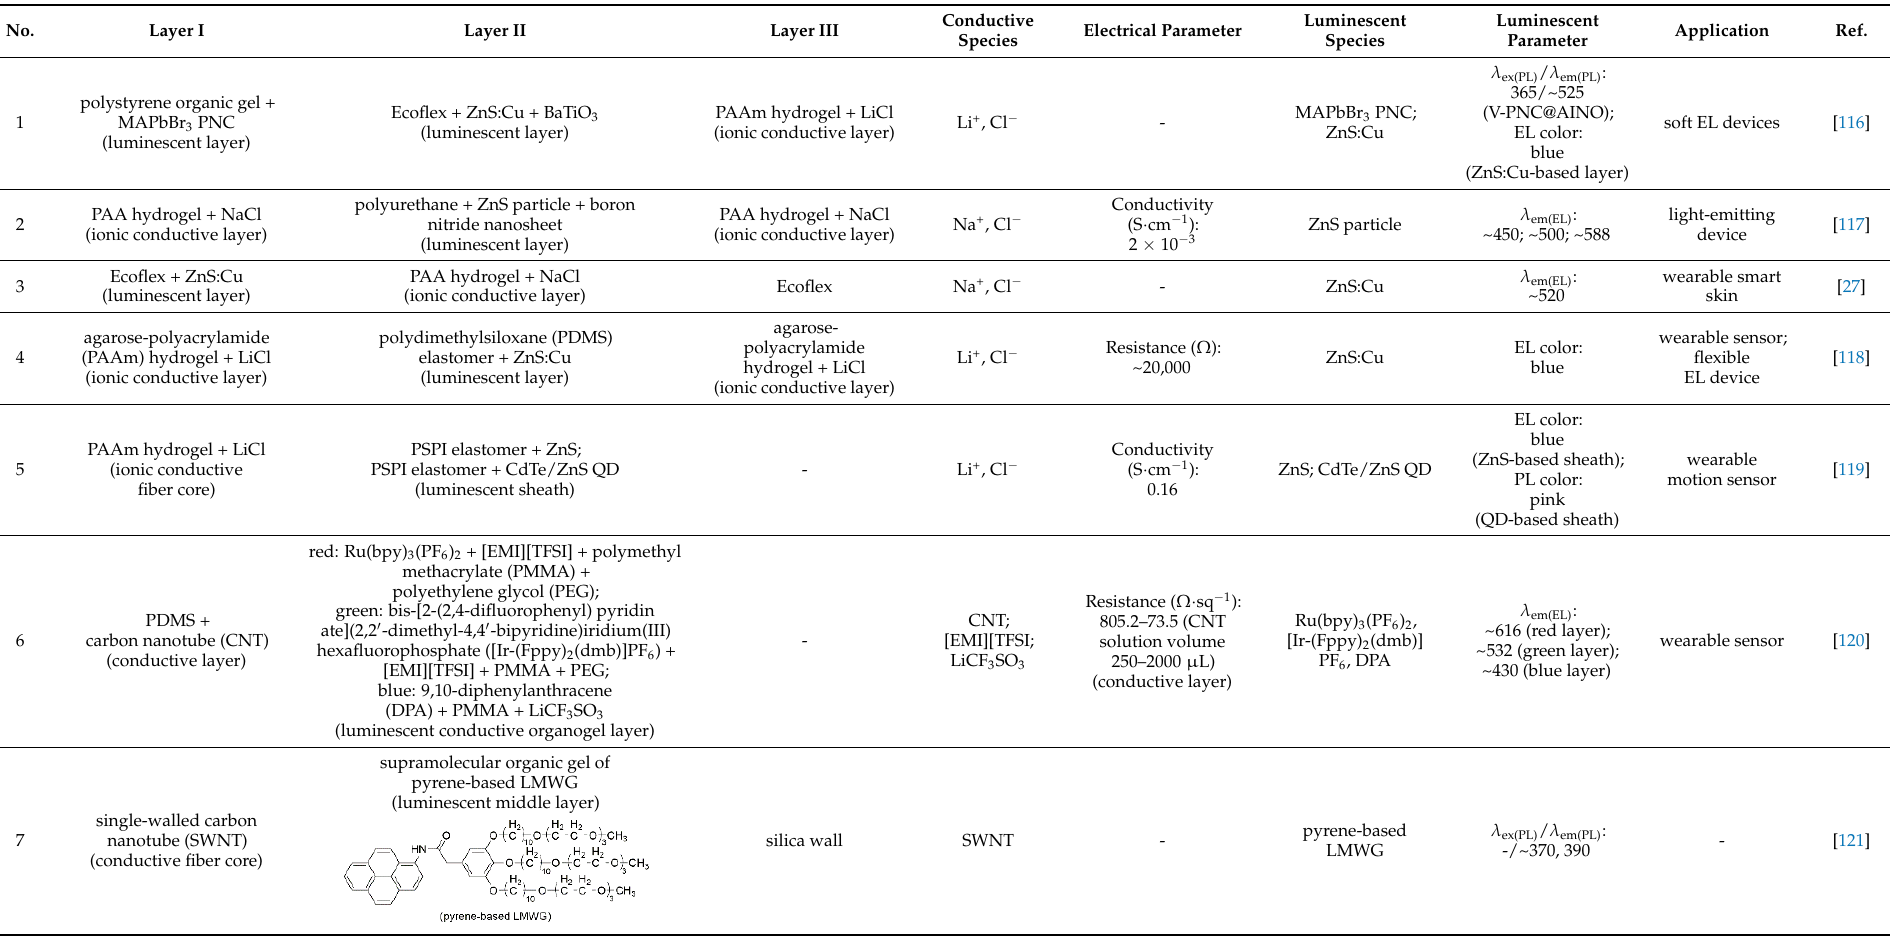
Table 2. Summary of information of typical luminescent conductive gel composites involved in this